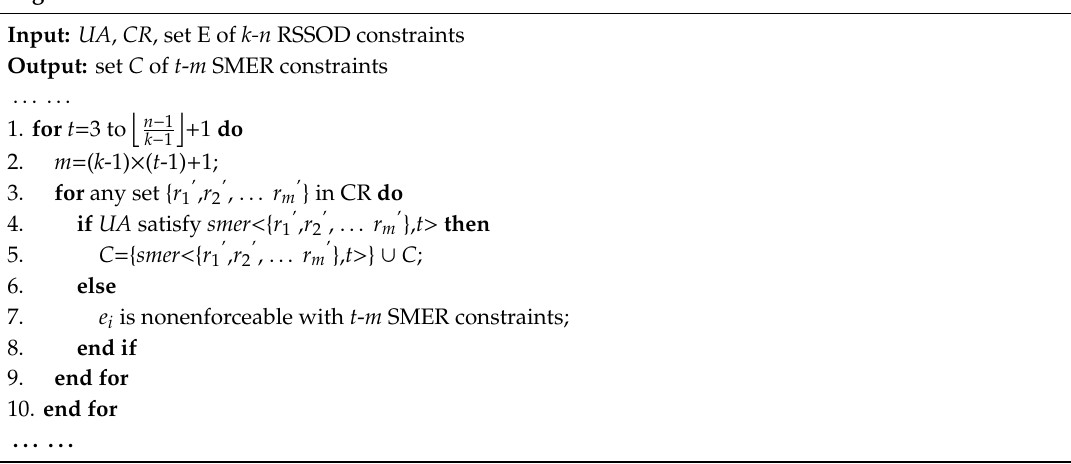
Algorithm 4. Construction of t - m SMER